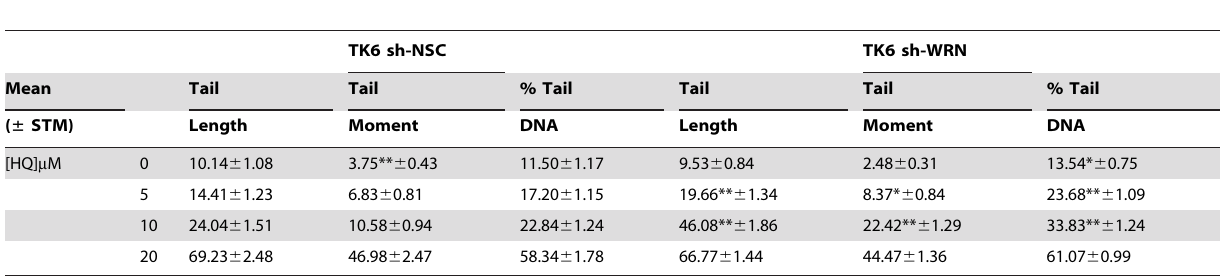
Table 2. DNA damage in TK6 cells treated with HQ for 6 hours analyzed by COMET